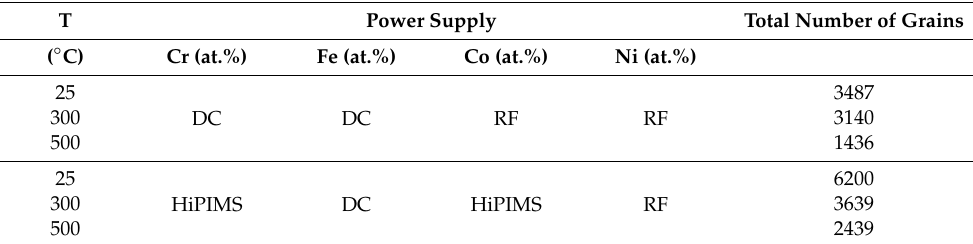
Table 3. Total number of grains determined with surface image analysis.